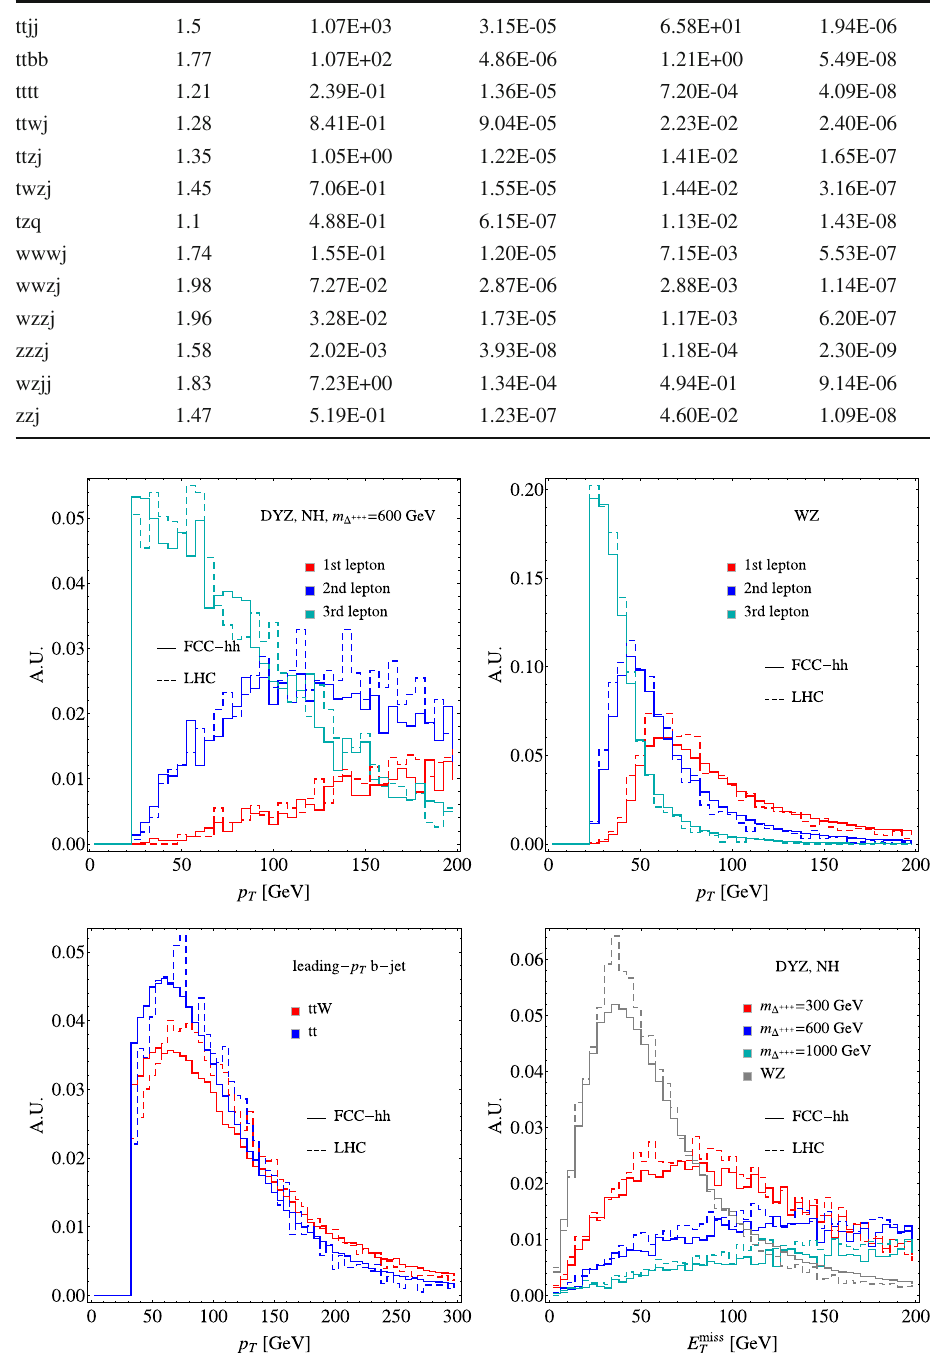
Table 2 Cross sections (in units of pb) of the backgrounds at 100/13 TeV before cuts and after cuts, which are denoted as σ ( 100 / 13 TeV ) and 0 σ ( 100 / 13 TeV ) , respectively. cut The K -factors for each process are listed in the second column. The notation of “aE ± 0b” stands for a × 10 ± b